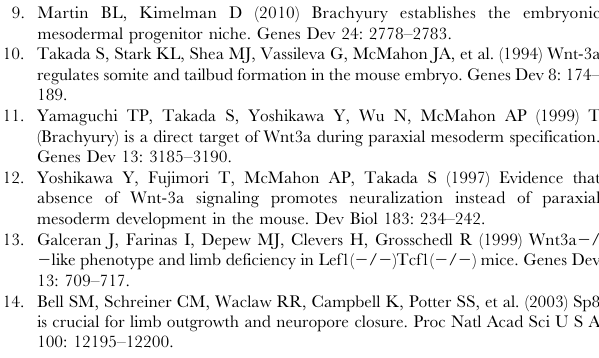
Figure S2 Wnt/wg gene regulatory network. Signal transduction pathway analysis (Genomatix, GePS software) identified 65 of the DEGs as members of the Wnt/wg gene regulatory network. Levels of differential gene expression are reflected by color and intensity: Green: down-regulated genes; Red: up-regulated genes Dashed lines highlight connections between network genes; diamonds indicate characterized and predicted promoter binding sites for connected factors; solid lines indicate interaction between proteins. (TIF) Figure S3 Genetic interaction between Sp5 and Sp8 . (TIF) Table S1 List of differentially expressed genes (DEG) deter- mined by comparing transcriptional profiles of Wnt3a 2 / 2 and wildtype PS/node. Table S2 Signal transduction pathway analysis of DEG. Table S3 Tissue-specific expression patterns associated with DEG. Table S4 qPCR primers used to analyze Sp1 -like family